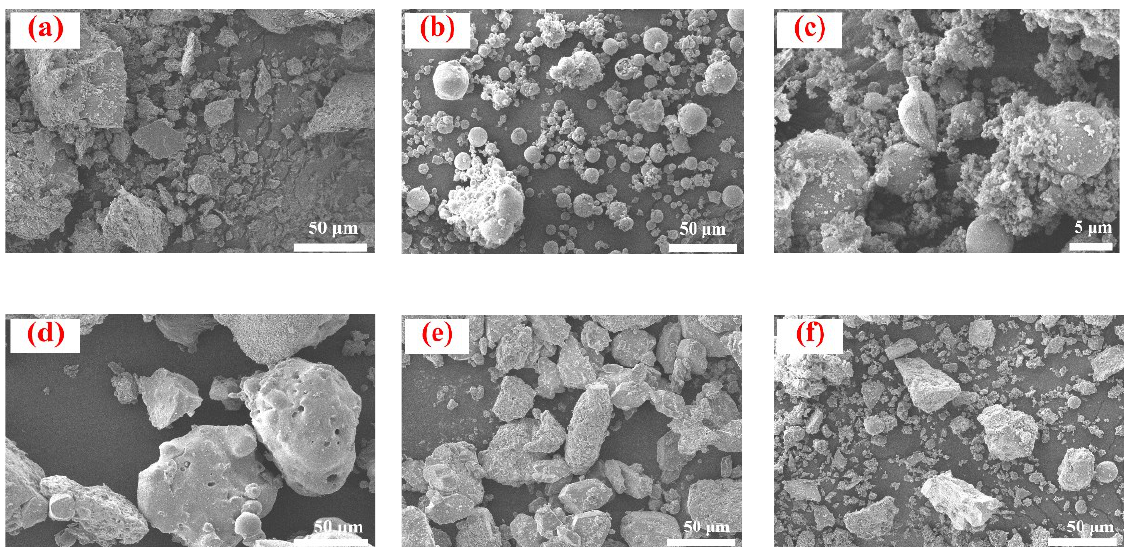
Figure 5. SEM microstructure of coal-based solid waste filling material, with ( a ) coal gangue, ( b ) fly ash, ( c ) gasification slag, ( d ) furnace bottom slag, ( e ) desulfurization gypsum, and ( f ) cement in the figure.